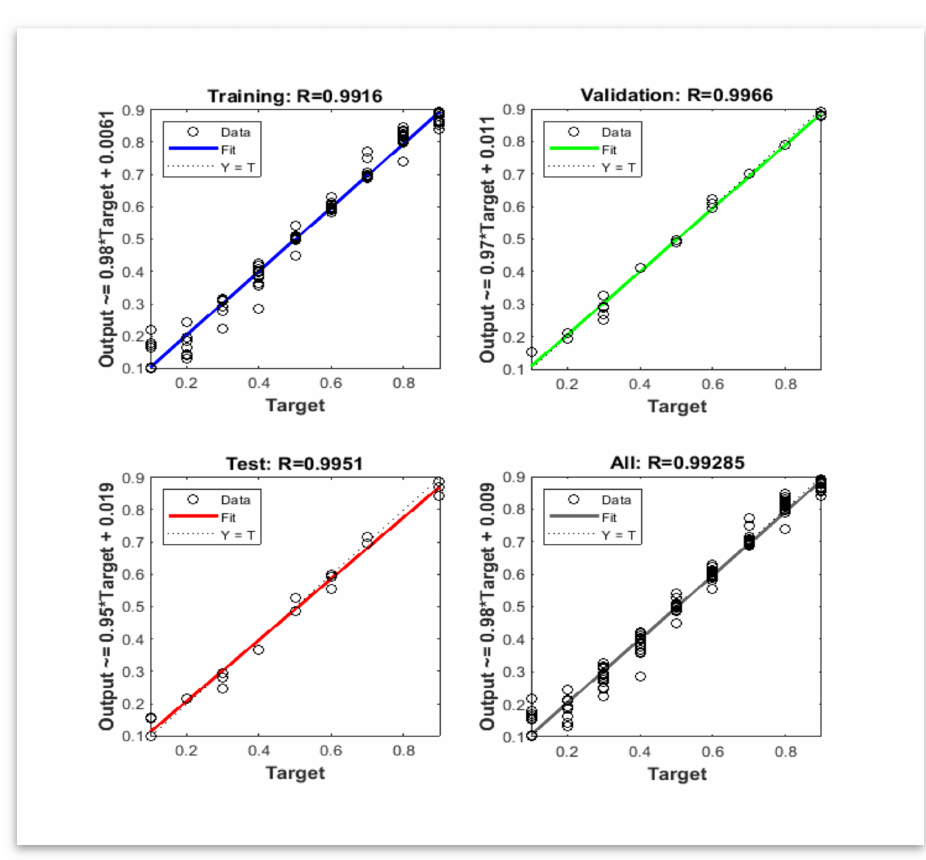
Figure 16. ANN performances during the training based on target